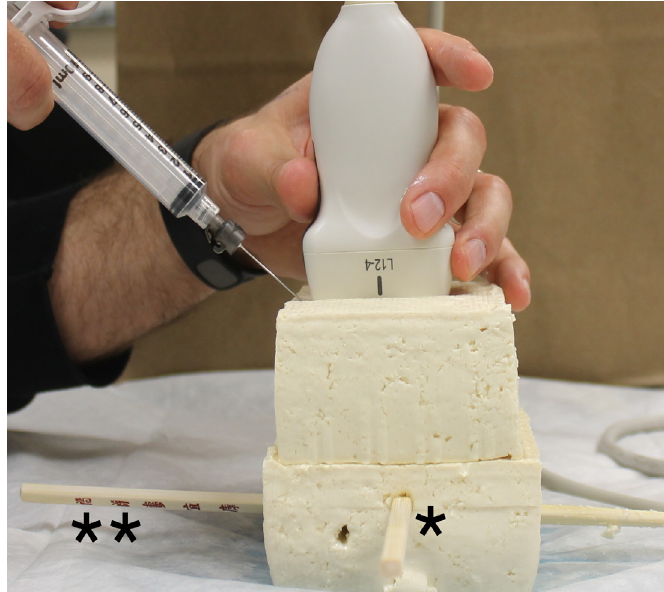
Figure 3. Difficult phantom model with hand-on-syringe approach. The simulated phantom model employed two sections of extra- firm tofu (10 by 8 by 4cm). Two wooden dowels were inserted through the tofu in perpendicular orientation to reflect a modeled nerve (*) and vessel (**). The modeled vessel was deeper and adjacent to the modeled